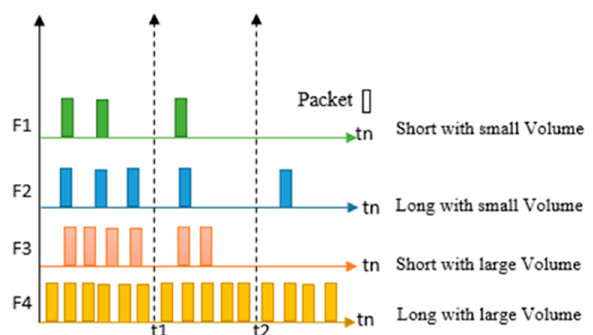
Figure 7. Taxonomy of flow entries management.